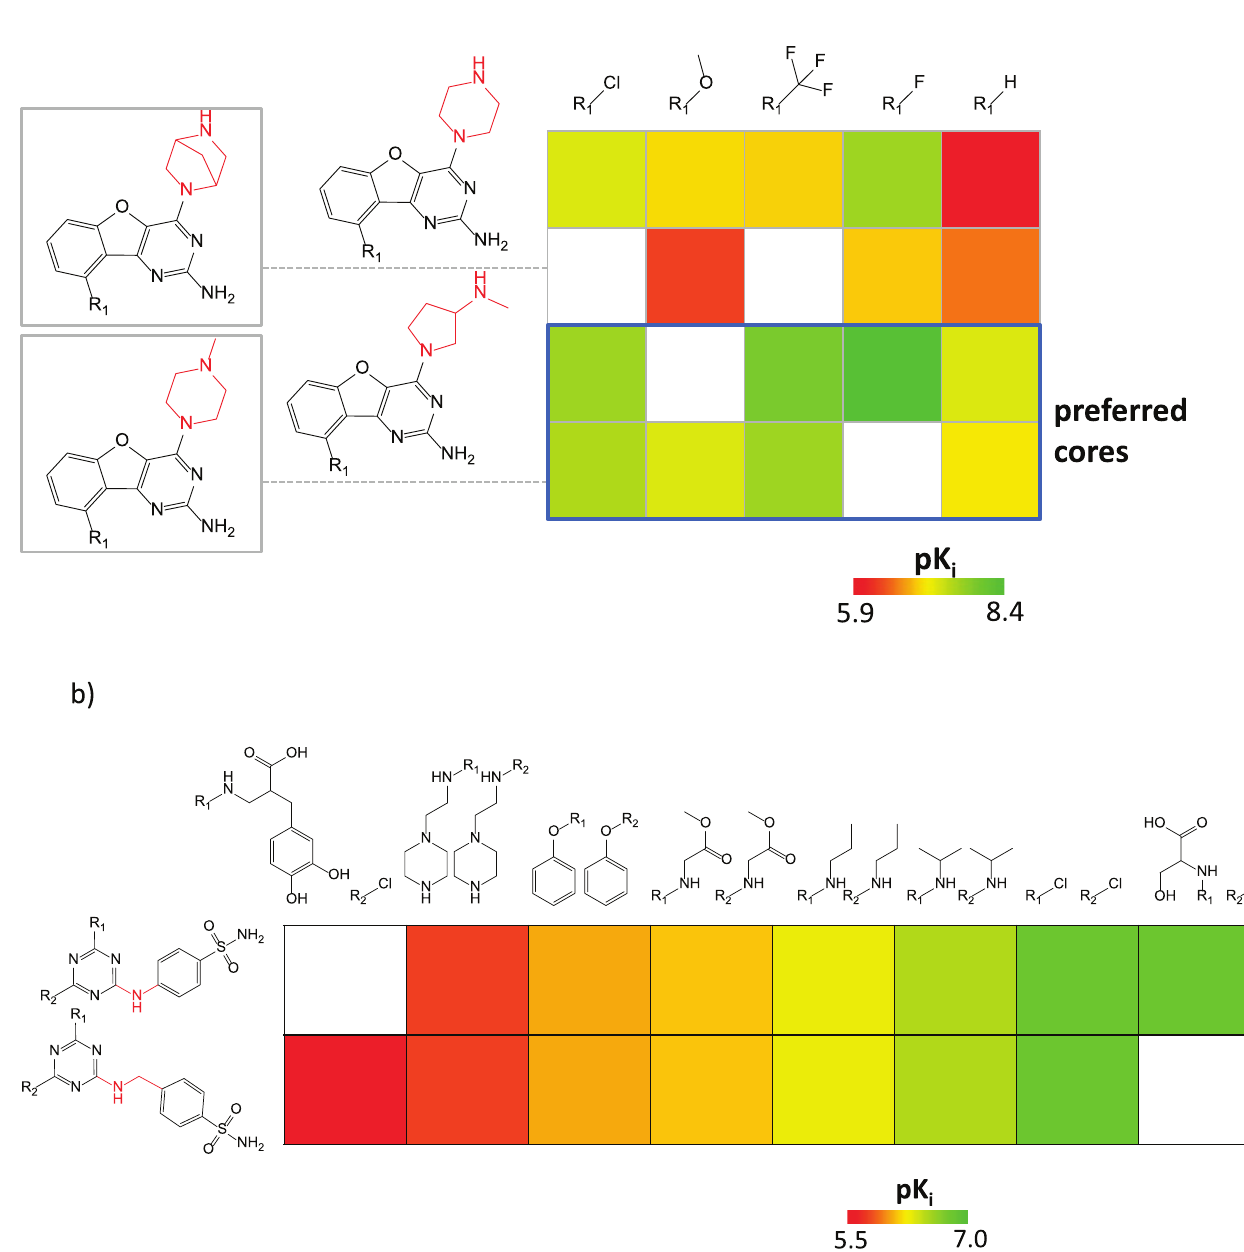
Figure 2. SAR patterns in matrices. In ( a ), a SARM capturing 16 ligands of the histamine H4 receptor is shown. Cells containing analogs with preferred cores yielding potent compounds are framed in blue. Substructures distinguishing the core fragments are highlighted in red. The pK value range for the 16 ligands is displayed. In ( b ), a subset of a double-cut SARM is shown that contains series of carbonic anhydrase I i inhibitors and an exemplary SAR transfer